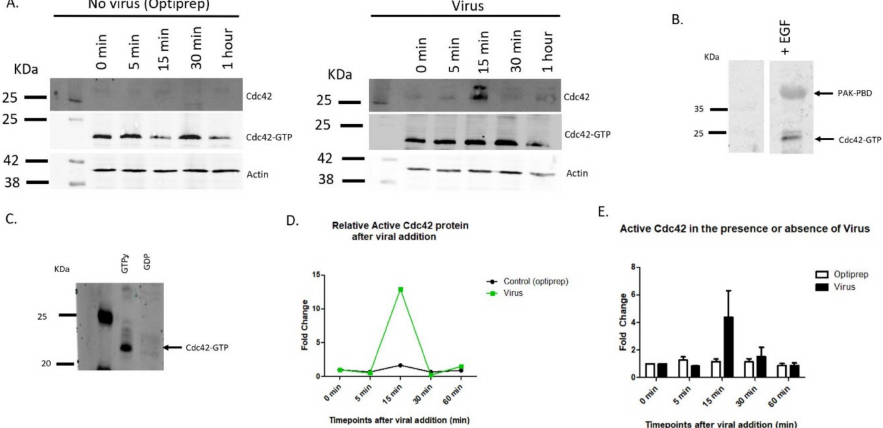
Figure 7. HPV16 activates Cdc42 protein at specific timepoints after viral addition. Active Cdc42 was evaluated with a pull-down using PAK-PBD coated beads. ( A ) Western blot of samples treated with (right side) or without (left side) virus for a single experiment. Blots for Cdc42 total protein, active Cdc42 (GTP bound), and actin. Levels of active Cdc42 was determined for cells incubated